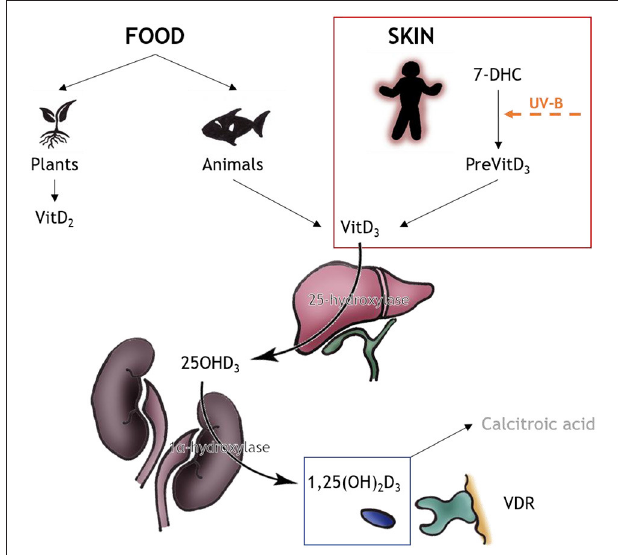
FIGURE 1 | VitD metabolism. VitD can be obtained from two sources, food (minor part) and skin (major part). The source for vitD 2 are plants and fungi, and the source of vitD 3 are animals, especially fatty fish. The major source of vitD 3 is produced nonenzymatically via the human skin: 7-DHC converts to PreVitD which isomerizes via heat to vitD 3 . In the liver, vitD 3 is converted to 25OHD 3 via 25-hydroxylase; in the kidneys the biologically active form 1,25(OH) 2 D 3 is produced via 1alpha-hydroxylase. The active product either can bind to VDR for correspondent outcome or is converted to calcitroic acid for storage. Information upon vitD metabolism obtained from (8); drawings by MT